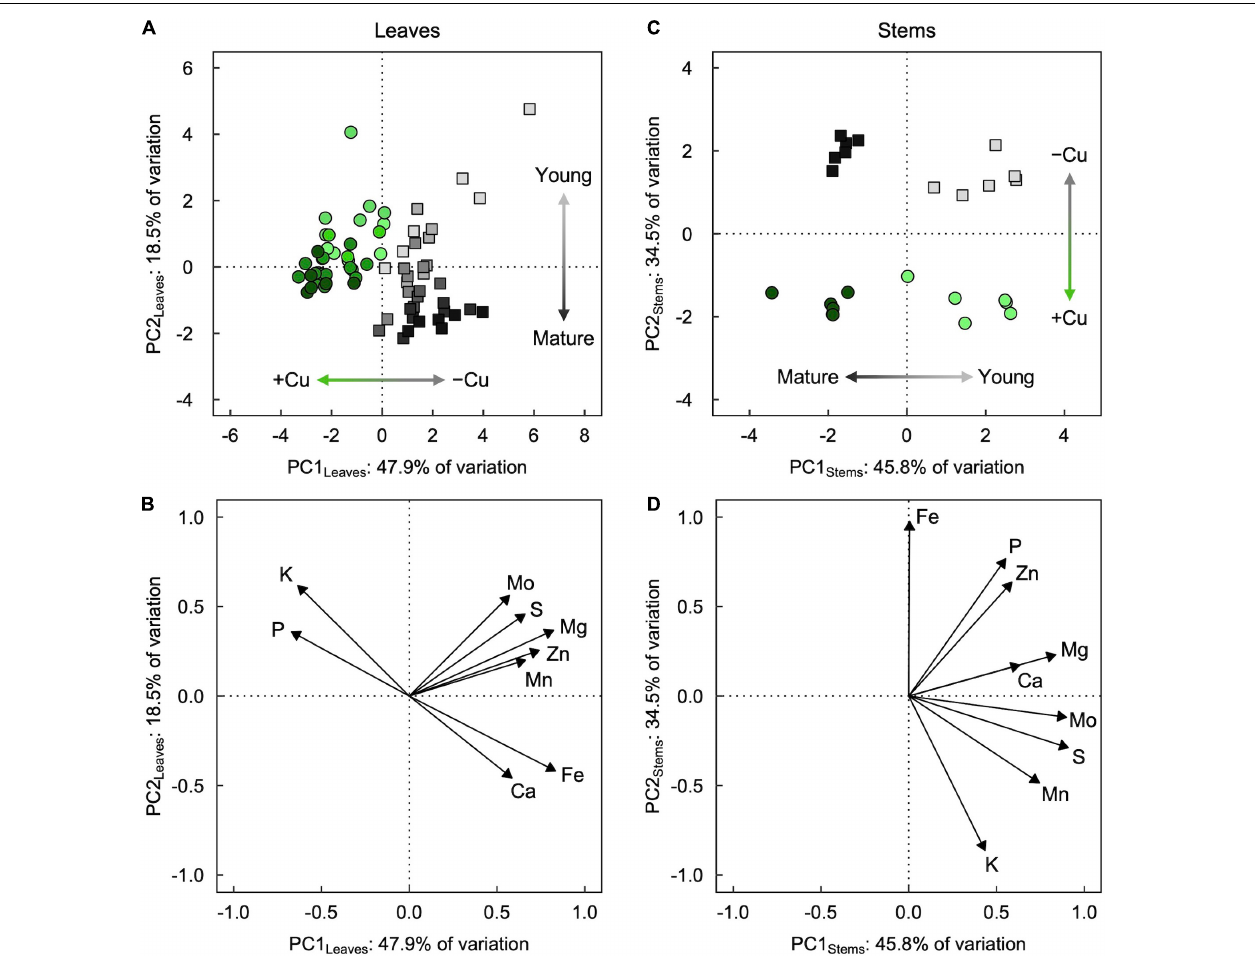
FIGURE 4 | (A,C) Score and (B,D) loading plots of the first two principal components from principal component analyses (PCA) of mineral partitioning in (A,B) leaves and (C,D) stems of hybrid white poplar ( P. tremula × P. alba ) grown in +Cu (green circles) and –Cu (gray squares) conditions. Results of two-way ANOVAs for the effects and interaction of tissue age and Cu feeding status on mineral partitioning in leaves as well as stems are shown in Table 1